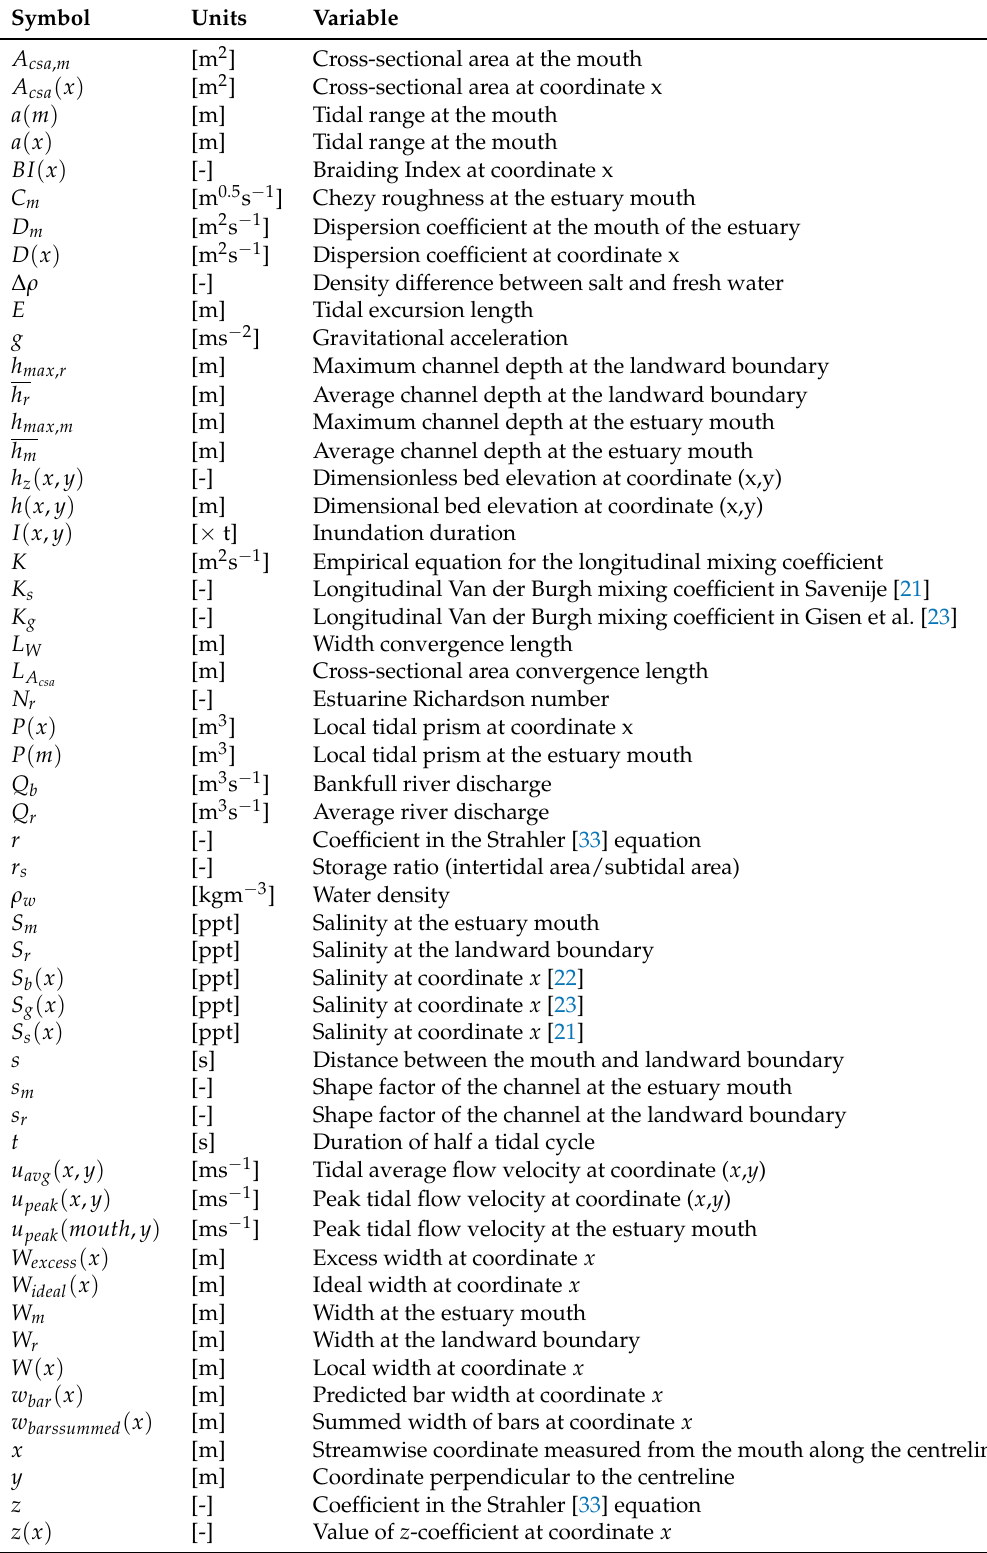
Table A1. List of symbols